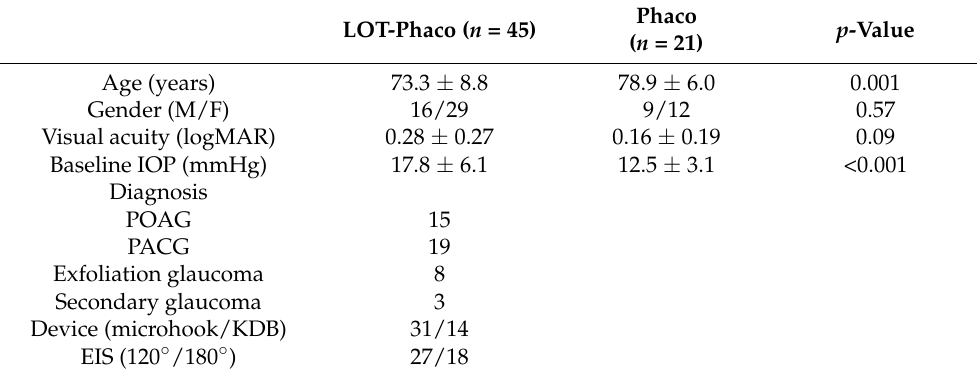
Table 1. Baseline patient